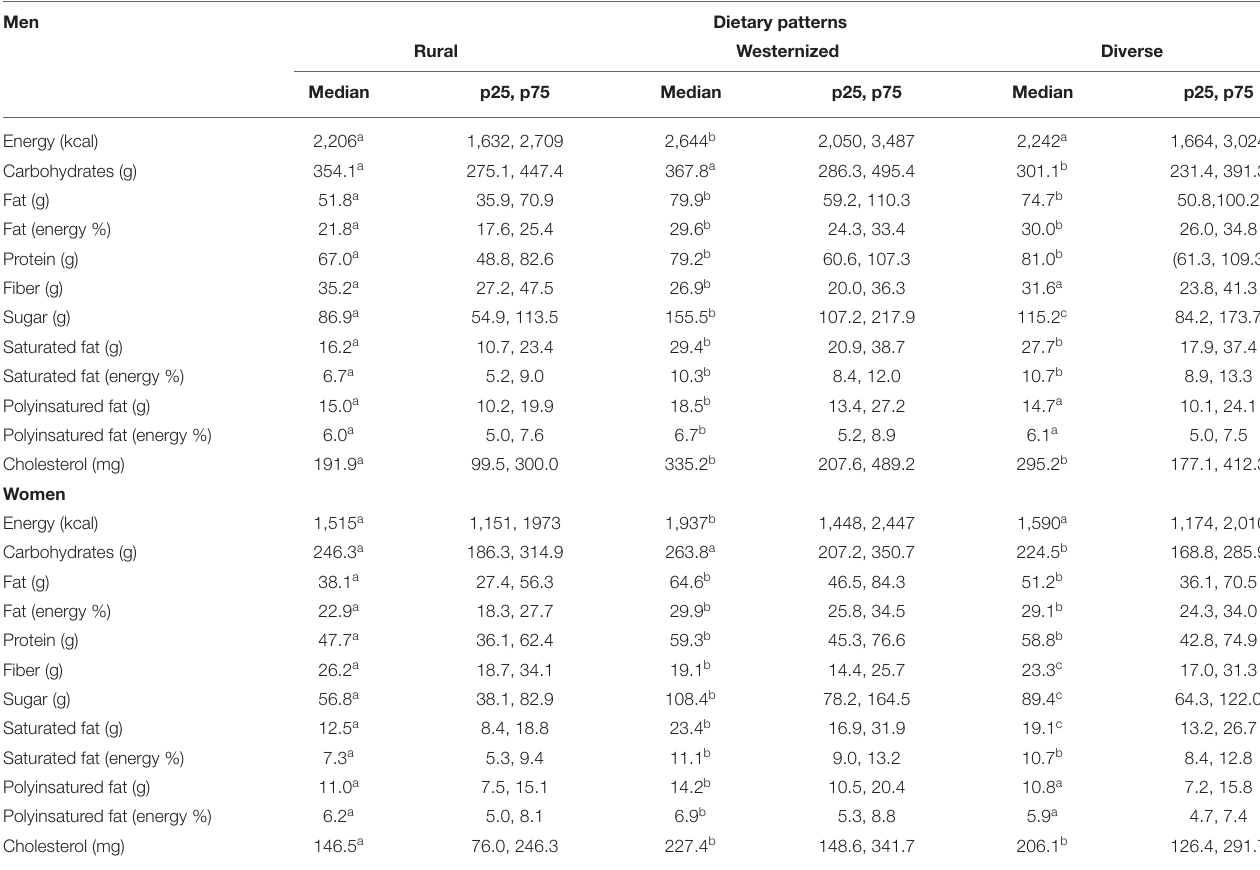
TABLE 3 | Daily energy and nutriments intake by dietary pattern and gender in Mexican adults ( n = 5,735) 1 . Men Dietary patterns Rural Westernized